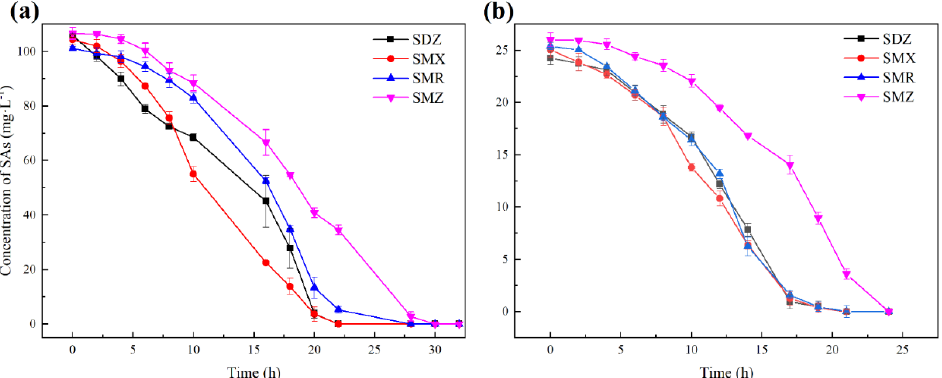
Figure 2. Changes in SAs concentration over time. ( a ) strain YL1 degraded 100 mg·L −1 SDZ, SMX, SMR, and SMZ, respectively; ( b ) Strain YL1 degrades a mixture of SDZ, SMX, SMR, and SMZ at an initial concentration of 25 mg·L −1 .